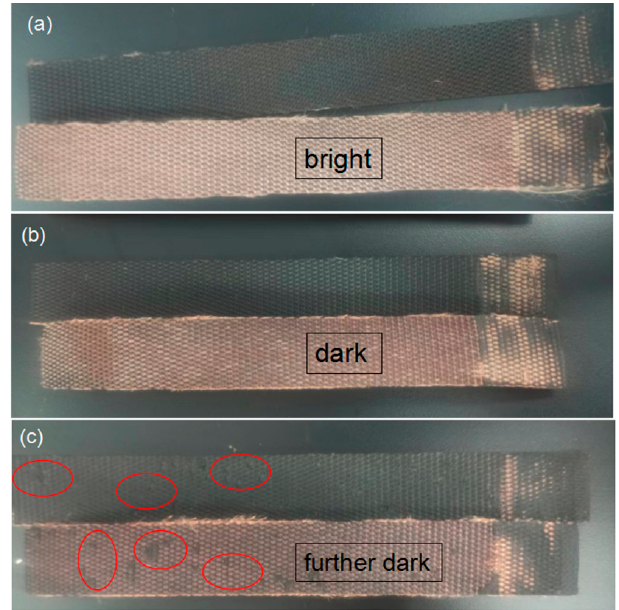
Figure 10. The photograph of interfacial fracture surface of fabric/rubber composites after the peel test. ( a ) original fabric/rubber, ( b ) 2 wt% alkali-treated fabric/rubber, ( c ) KH550-grafted fabric/rubber.